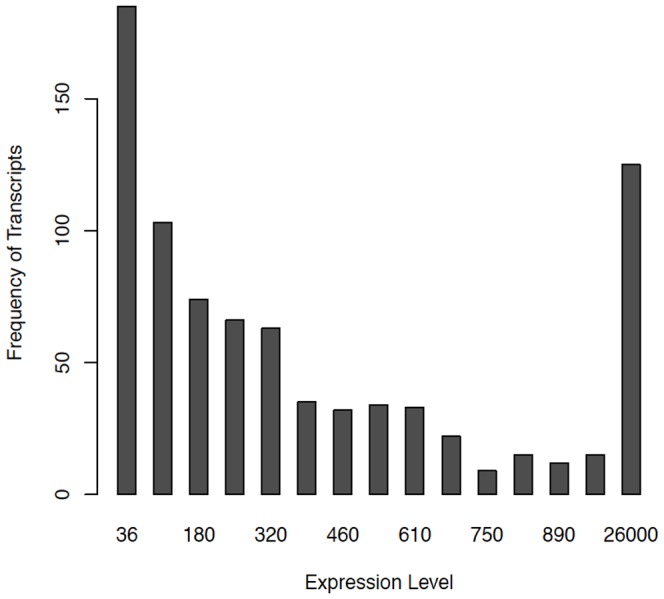
Distribution of expression levels of the predicted transcripts.The last bin sums from the expression levels 1000 to 50,000. The expression levels were measured as the average of reads mapped on predicted transcripts.